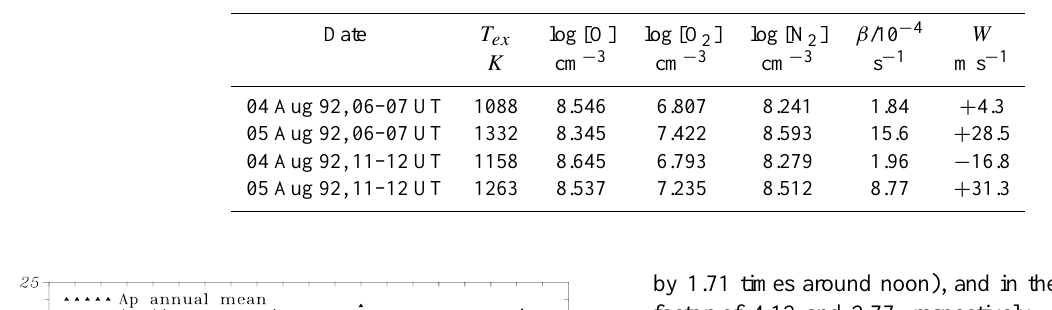
Table 2. Calculated at 300 km thermospheric parameters for quiet 04 August 1992 and disturbed 05 August 1992 days and two periods of the day